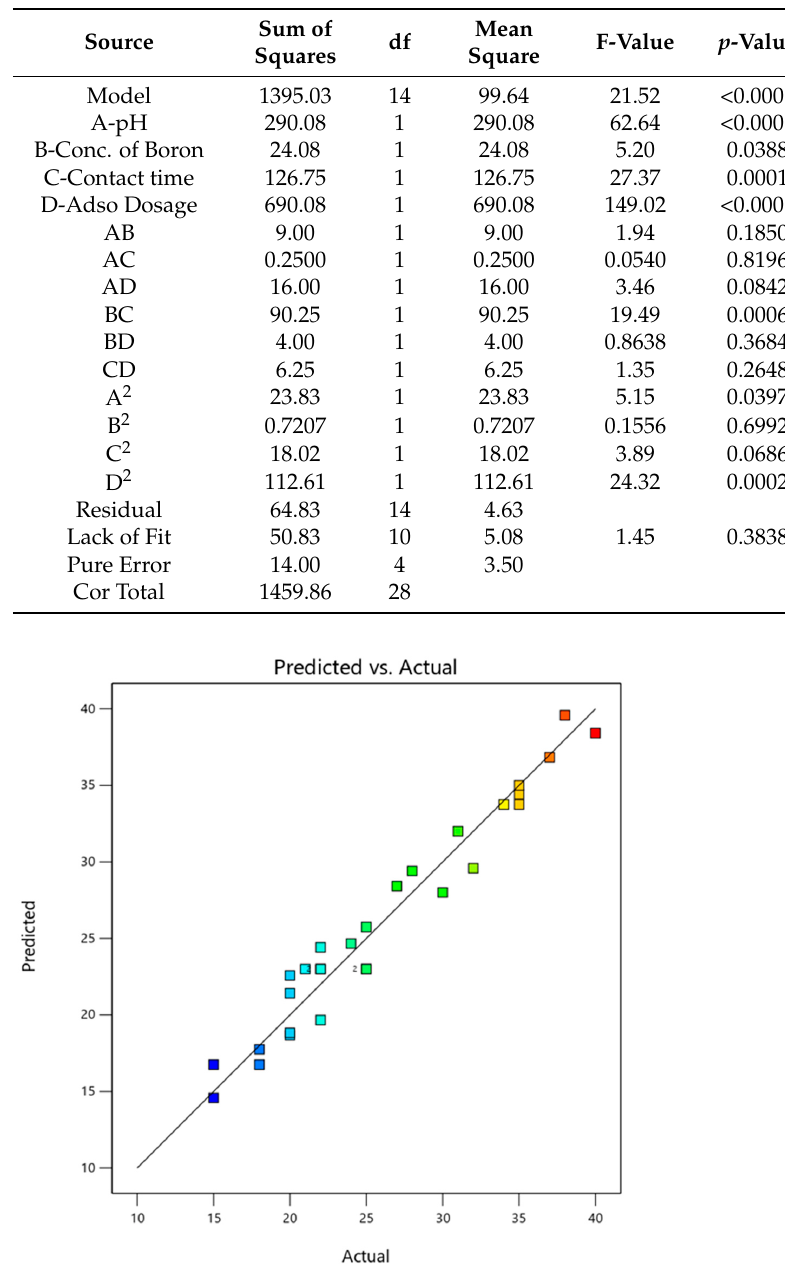
Table 4. ANOVA of Quadratic Model of CRB05 with the response of surface area.